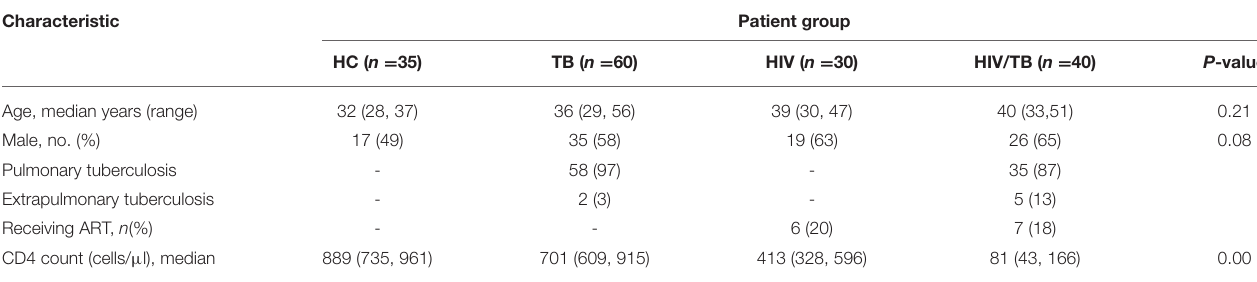
TABLE 1 | Clinical characteristics of study population.